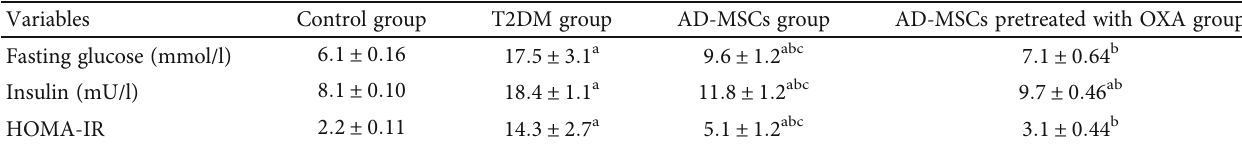
Table 2: Fasting glucose, insulin, and HOMA-IR pro fi les in di ff erent study groups. Variables Control group T2DM group AD-MSCs group AD-MSCs pretreated with OXA group Fasting glucose